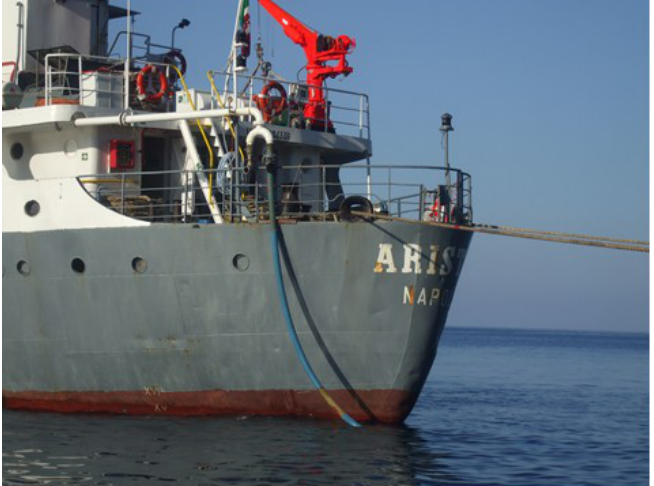
Figure 6. Picture of a vessel taken during the operation of water distribution at Filicudi, one of the Eolian